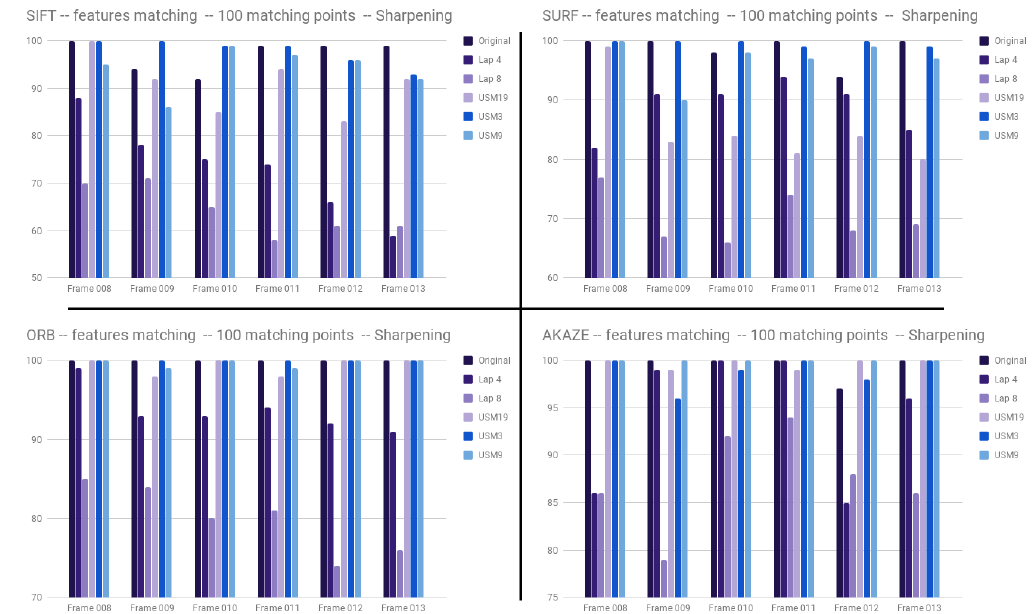
Figure 11. Inliers percentage depending on the frame and the sharpening technique for SIFT, SURF, ORB and AKAZE. Table 1. KPI (%) given by PD algorithm after sharpening using Laplacian filters or unsharp